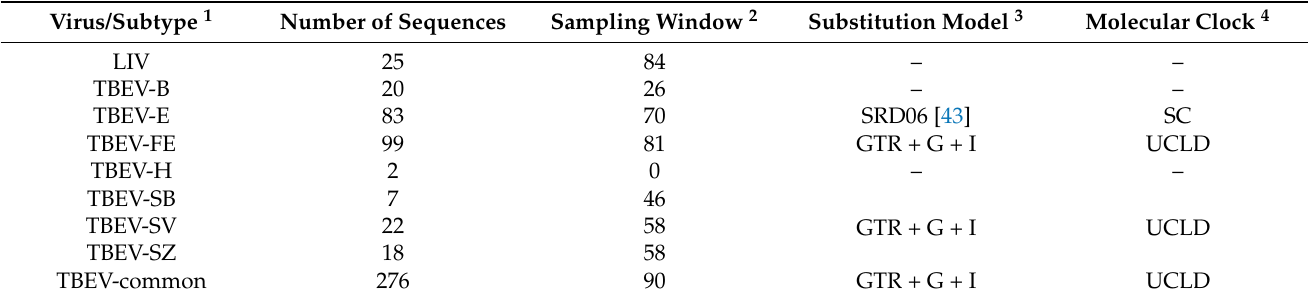
Table 1. The data set composition and model combination